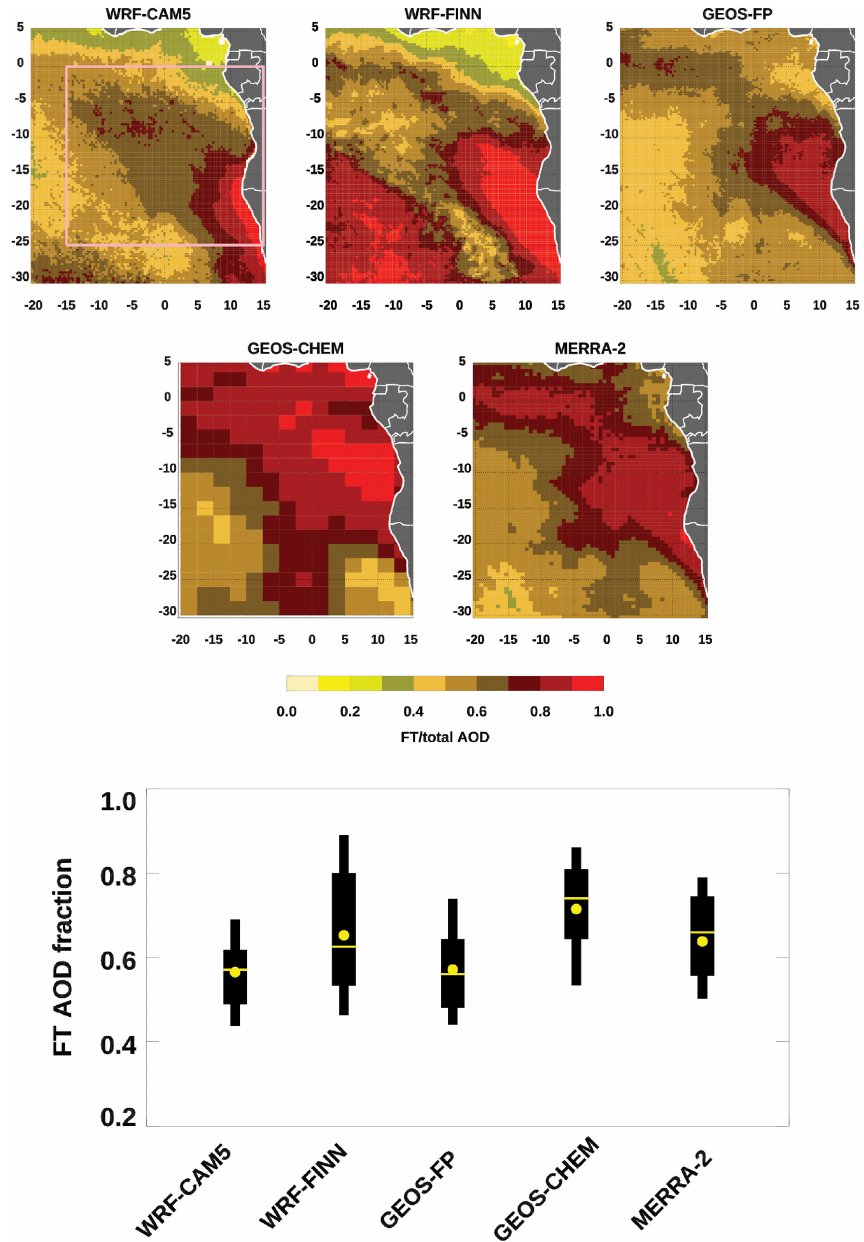
Figure 4. The same as Fig. 3 but for August